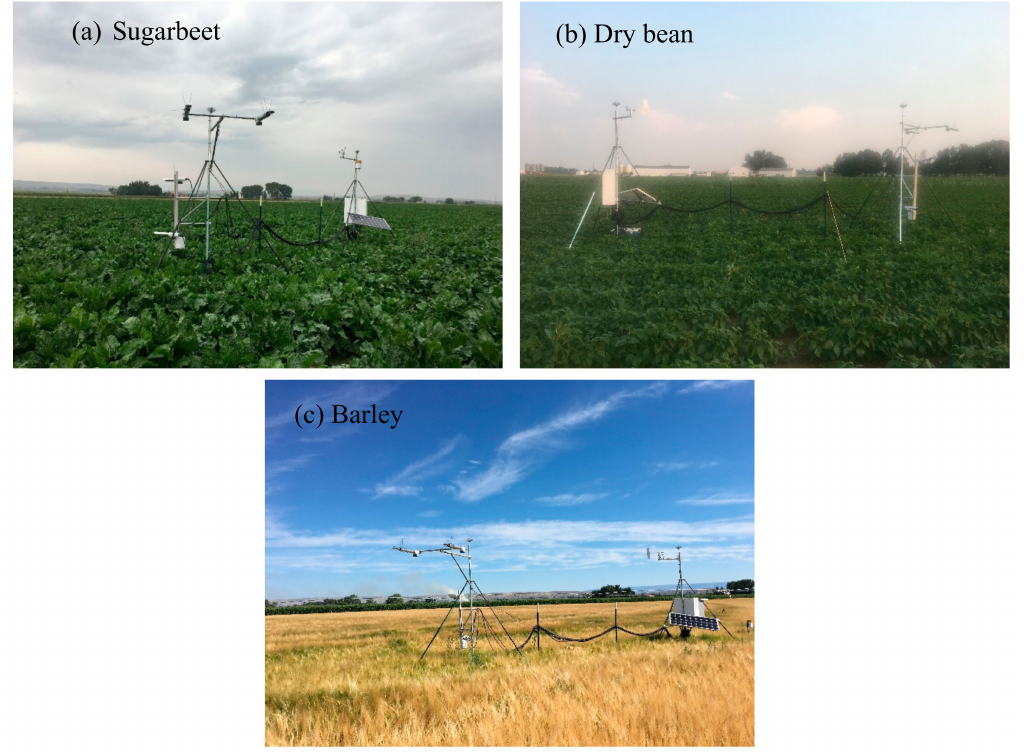
Figure 2. Bowen Ratio Energy Balance System (BREBS) installed in center pivot irrigated ( a ) sugar beet, ( b ) dry bean, and ( c ) barley field at Powell Research and Extension Center in Powell,